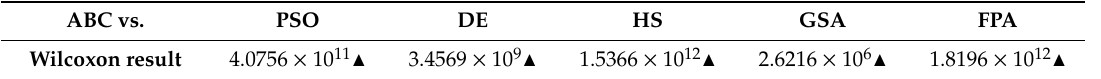
Table 7. p -values of the Wilcoxon test comparing ABC vs. PSO, DE, HS, GSA and FPA. ABC vs.